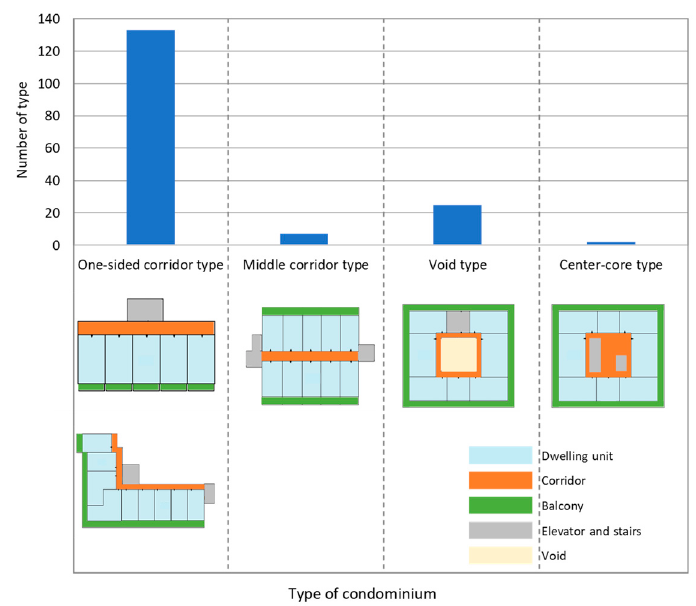
Figure 5. The statistical data of the condominium stock in Japan (Figures are made by given data) [30]